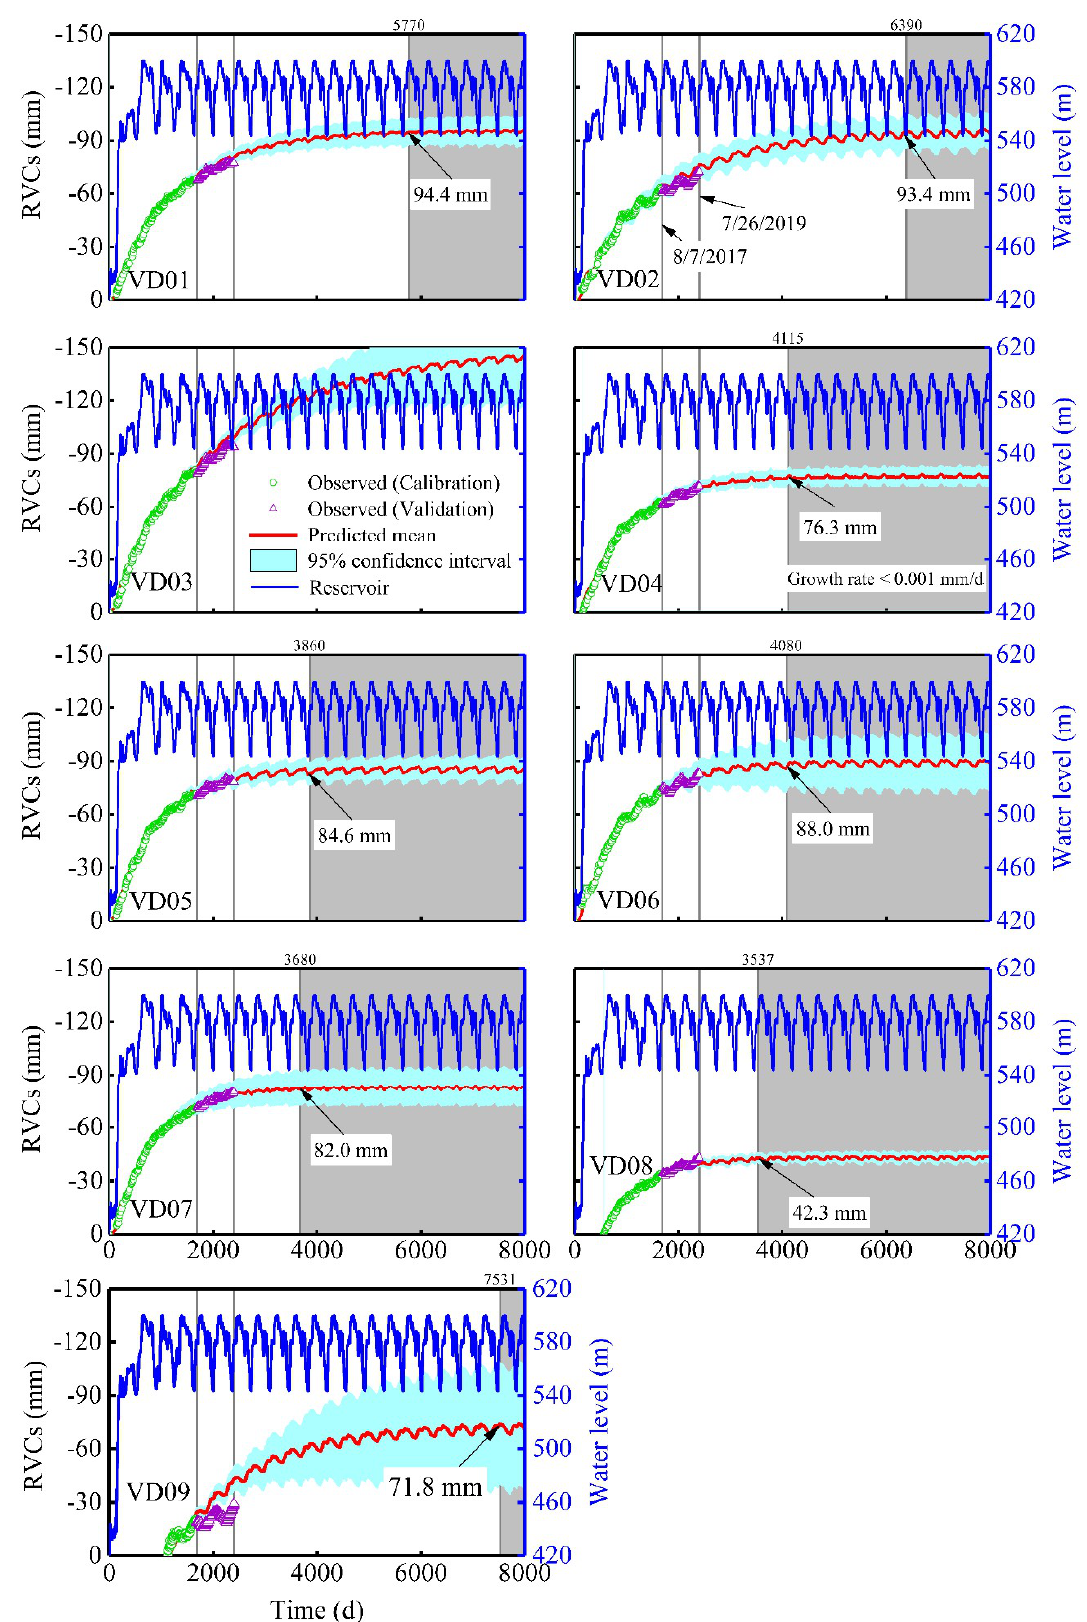
Figure 9. Prediction of RVC development. The red line represents the predicted mean value of the RVCs and the blue line represents the reservoir water level. Green circles and purple triangles represent observed RVCs.